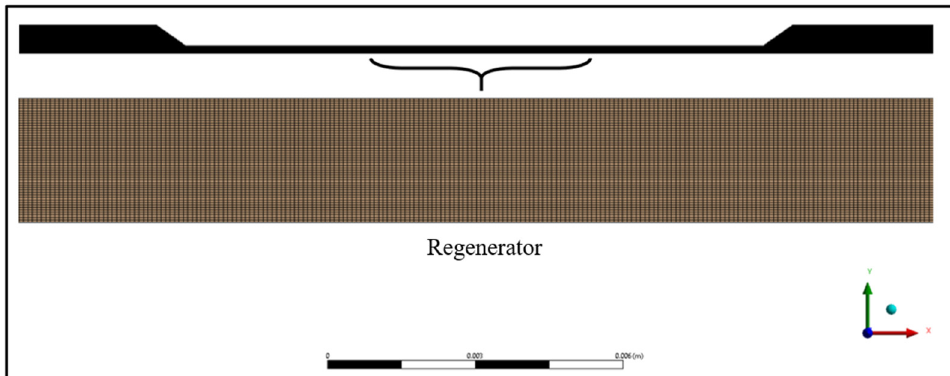
Figure 7. Meshing of the numerical model.